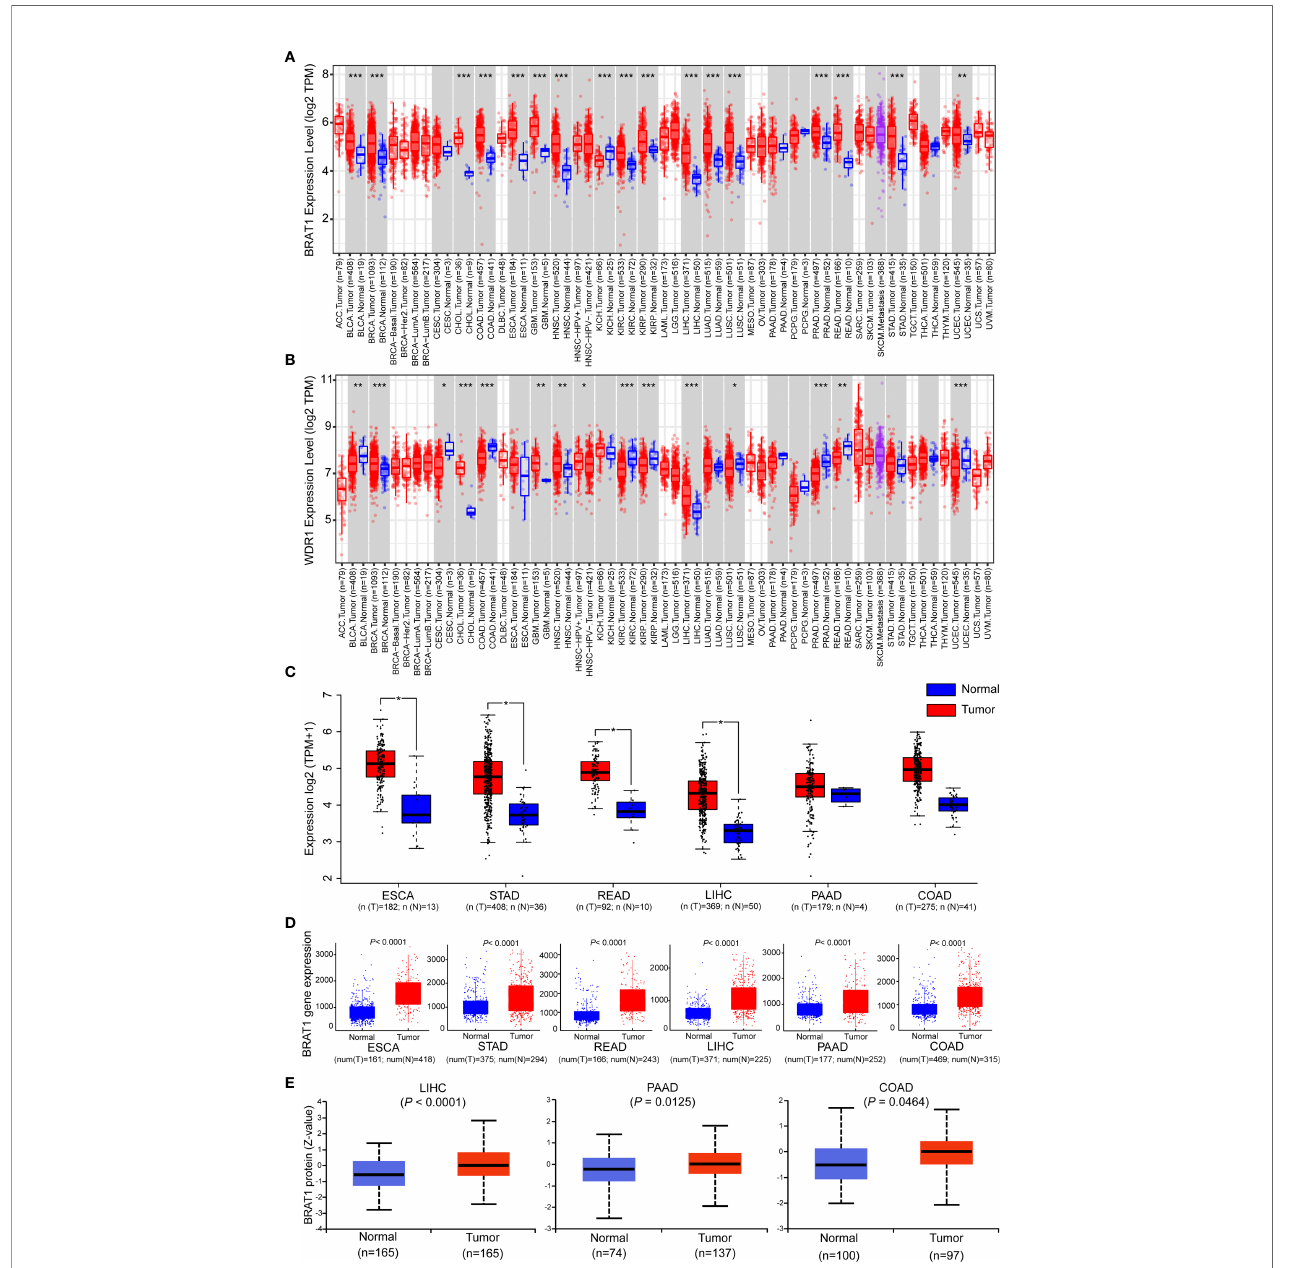
FIGURE 4 | Comparison of BRAT1 levels between normal and gastrointestinal cancer tissues. (A, B) The expression levels of human BRAT1 and WDR1 in different cancer types were obtained from TCGA data in TIMER. (C) For the main type of gastrointestinal cancer, including ESCA, STAD, READ, LIHC, PAAD and COAD in the TCGA project, the normal tissues of the TCGA normal data were as controls. The box plot data were obtained from GEPIA web-based tool. (D) Plots of BRAT1 expression in normal and gastrointestinal cancer tissues of based on gene chip data of TNMplot. (E) BRAT1 proteomic expression pro fi le in gastrointestinal cancers, LIHC, PAAD and COAD from CPTAC samples. Standard deviations from the median across samples for the given cancer types were represented by Z values. n represents the number of samples. * P < 0.05, ** P < 0.01, *** P <